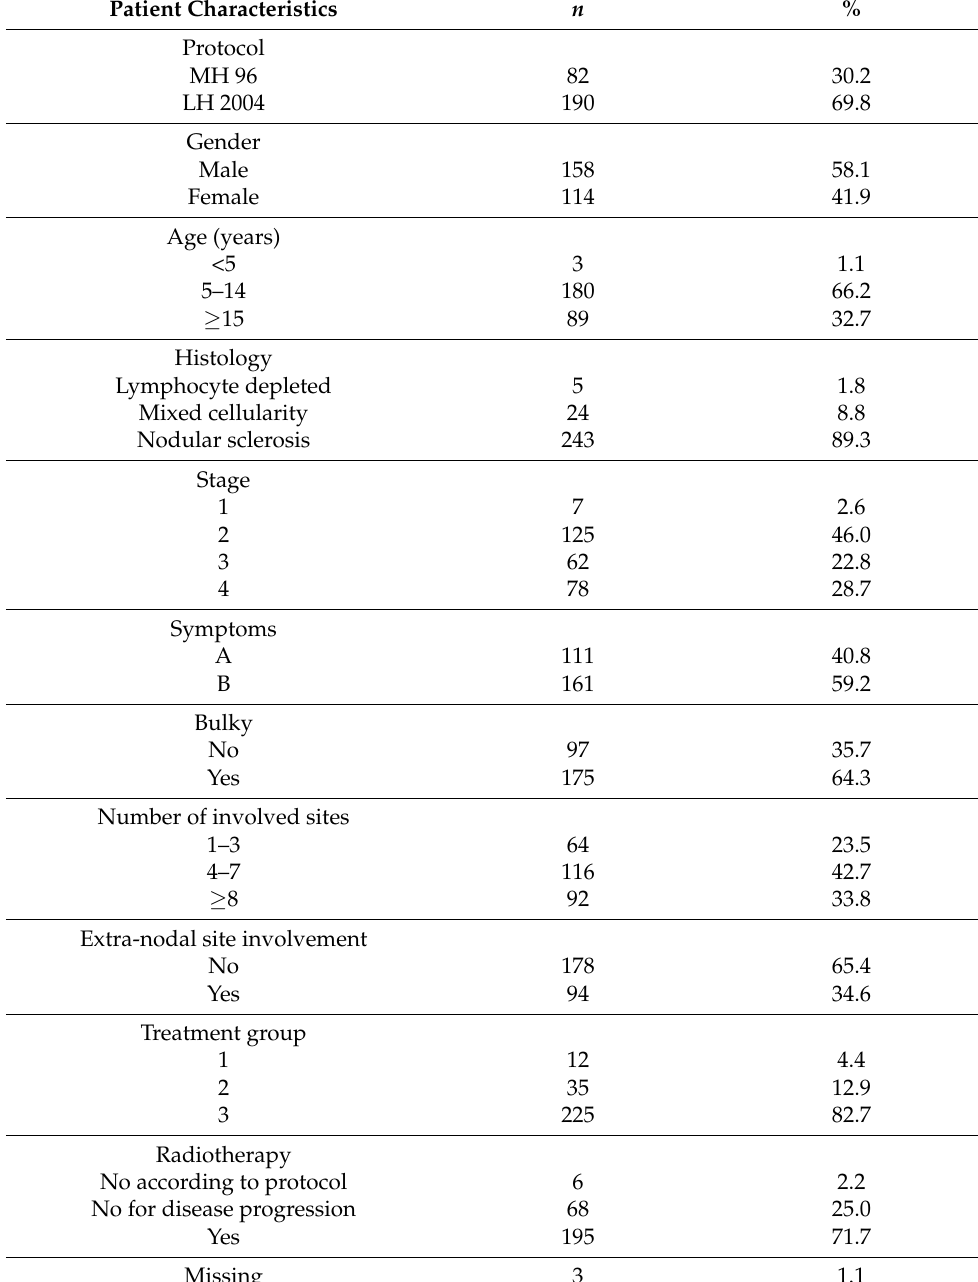
Table 3. Characteristics at diagnosis of 272 recurring patients with classical Hodgkin’s